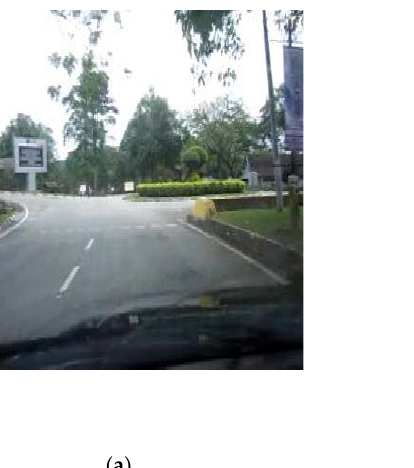
Figure 20. Autonomous detection and navigation of the proposed system in the road roundabout